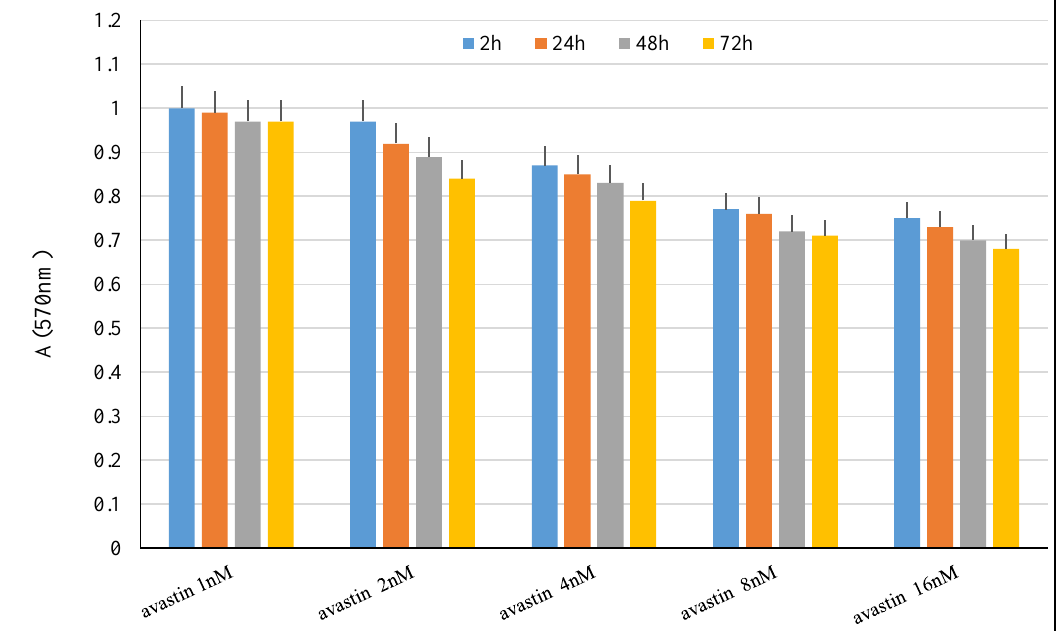
Figure 5B. Effect of avastin on viability of SW480 cells.